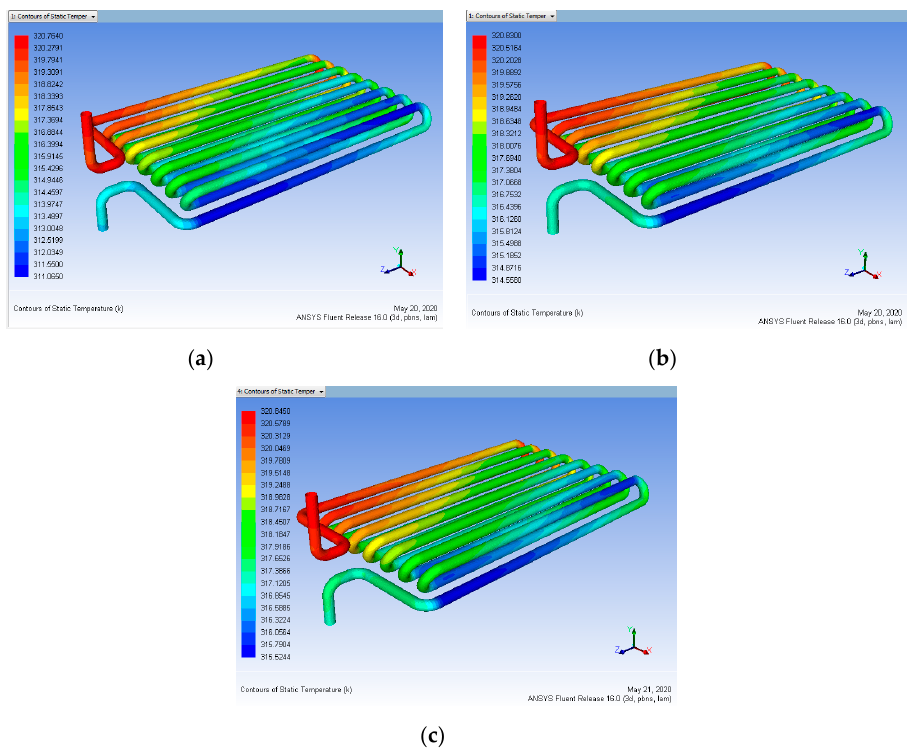
Figure 13. Heat input 323 K vs. Coating Thickness 80 µm for mass flow rate ( a ) 0.15, ( b ) 0.30, ( c ) 0.45 L/min (After Coating).